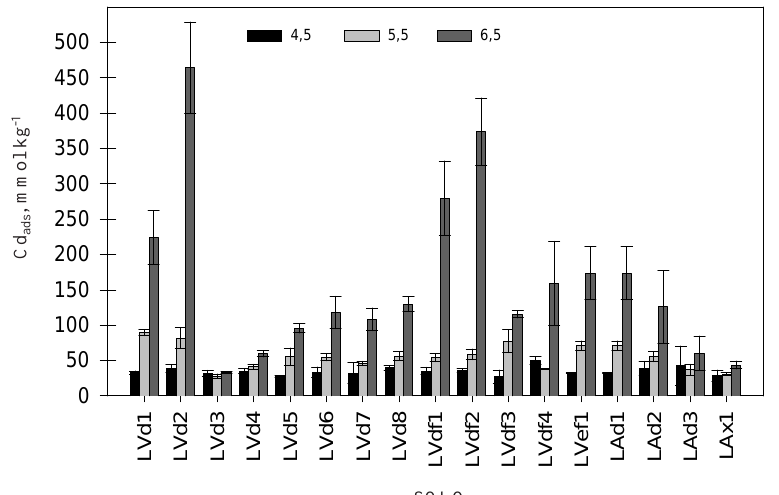
Figura 2. Valores do coeficiente de afinidade (Kd) para Cd em amostras de 17 Latossolos (LVd = Latossolo Vermelho distrófico típico; LVdf = Latossolo Vermelho distroférrico típico, LVef = Latossolos Vermelho eutroférrico típico; LAd = Latossolo Amarelo distrófico típico; LAx = Latossolo Amarelo coeso) ) provenientes de diversas regiões geográficas do Brasil, obtidos após reação das mesmas com Cd(NO 3 2 0,20 mmol L -1 , em três valores pH (4,5; 5,5; e 6,5) da solução de equilíbrio Ca(NO ) 5 mmol L -1 . As 3 2 barras de erro representam o desvio-padrão (n = 3). Quadro 4. Coeficientes de correlação de Pearson (r) entre alguns atributos dos solos e a quantidade de ) e a fração de Cd dessorvida [Cd = (Cd /Cd ) x 100] de Latossolos Cd adsorvida (Cd ads %des dessorvido adsorvido brasileiros, em três valores de pH